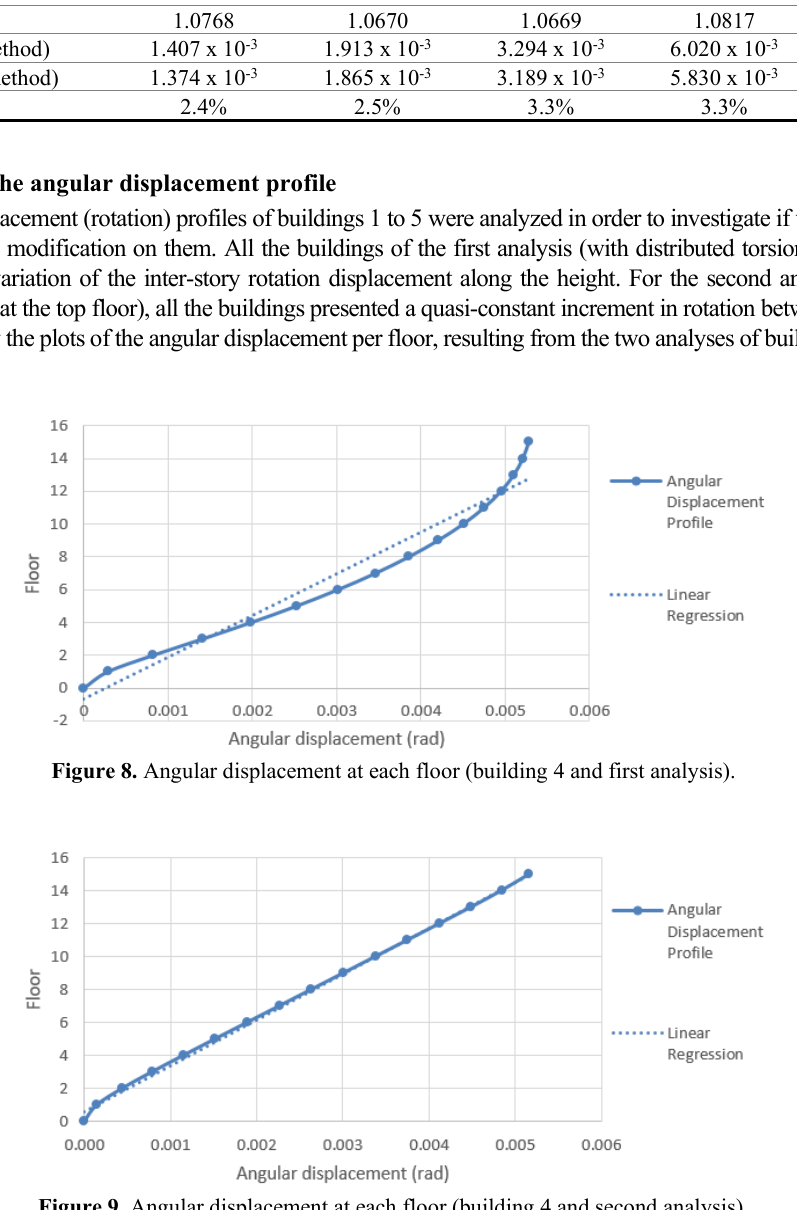
Figure 9. Angular displacement at each floor (building 4 and second